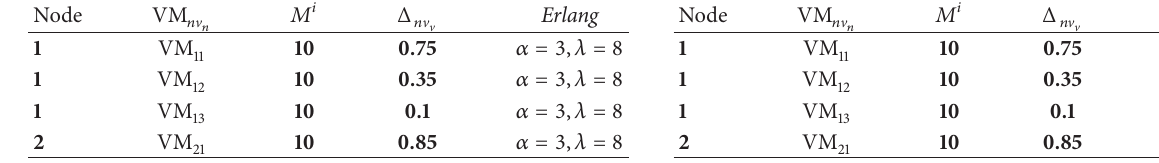
Table 5: Without communications. Low optimal Erlang . Preserving